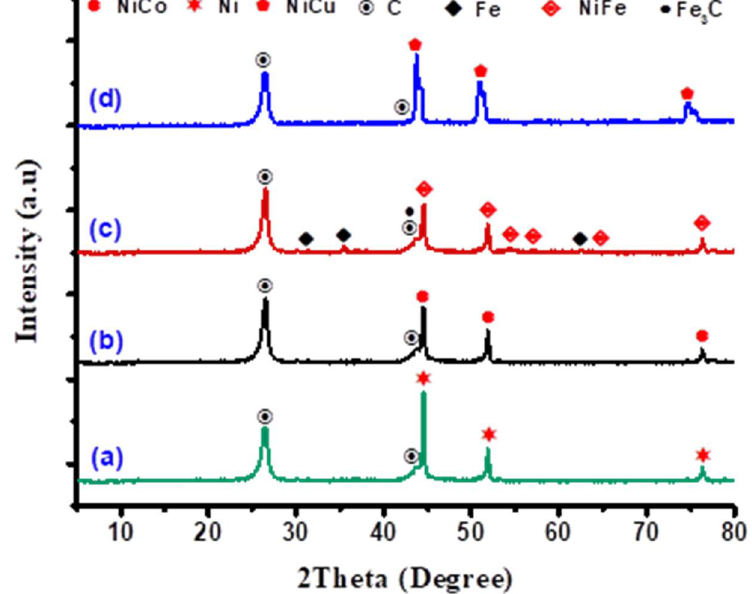
Figure 12. XRD patterns of the carbonous materials obtained after the reaction for ( a ) Ni, ( b ) Ni-Co, ( c ) Ni-Fe, and ( d ) Ni-Cu catalysts.